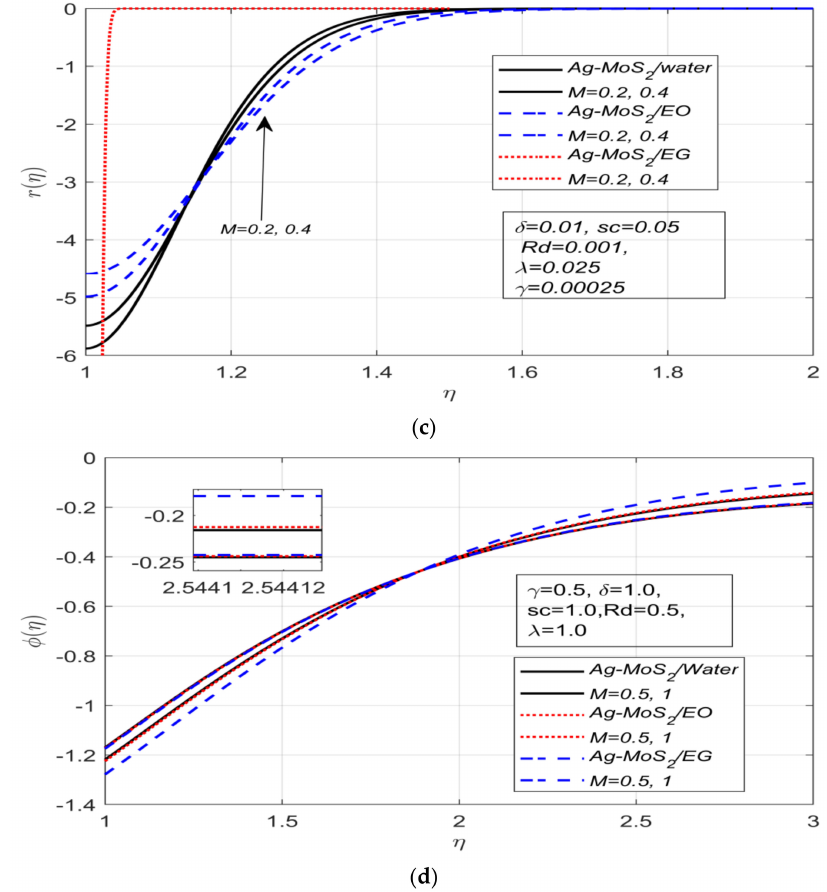
Figure 2. ( a ) The influence of M on the primary velocity p (cid:48) . ( b ) The influence of M on the secondary velocity q (cid:48) . ( c ) The impact of M on the temperature profile r . ( d ) The impact of M on the concentration profile φ